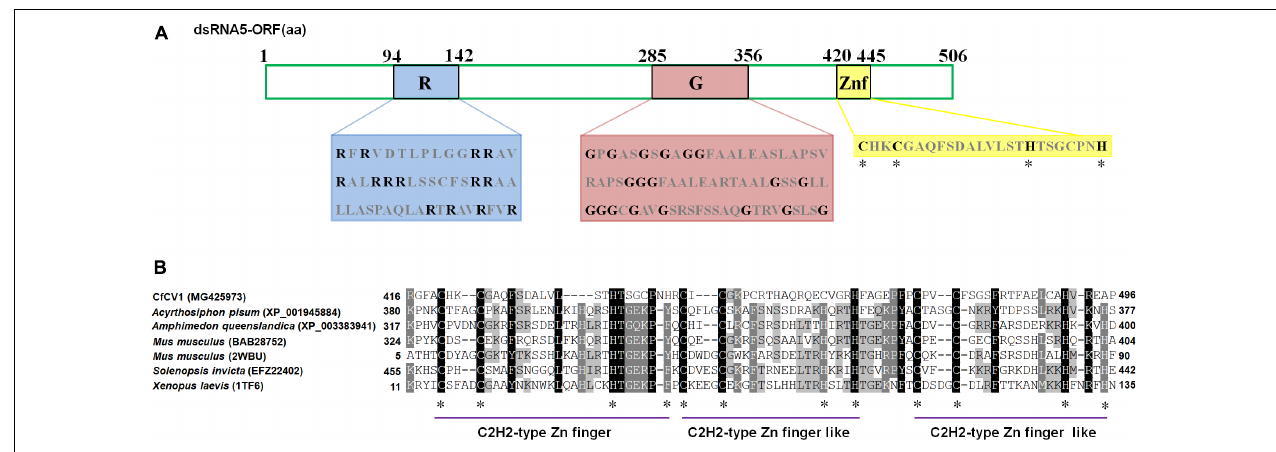
FIGURE 2 | The diagrammatic C2H2-type zinc finger protein. (A) The zinc finger protein with an arginine-rich region (94–142) and a glycine-rich region (285–256). The arginine (R) and glycine (G) residues were indicated by black letters, and other amino acid residues were shown by gray letters. (B) Multiple sequence alignment of zinc finger protein in CfCV1 and some animals. The alignments were produced in MAFFT and visualized using the BoxShade program. “ ∗ ” indicates identical cysteine and histidine residues.